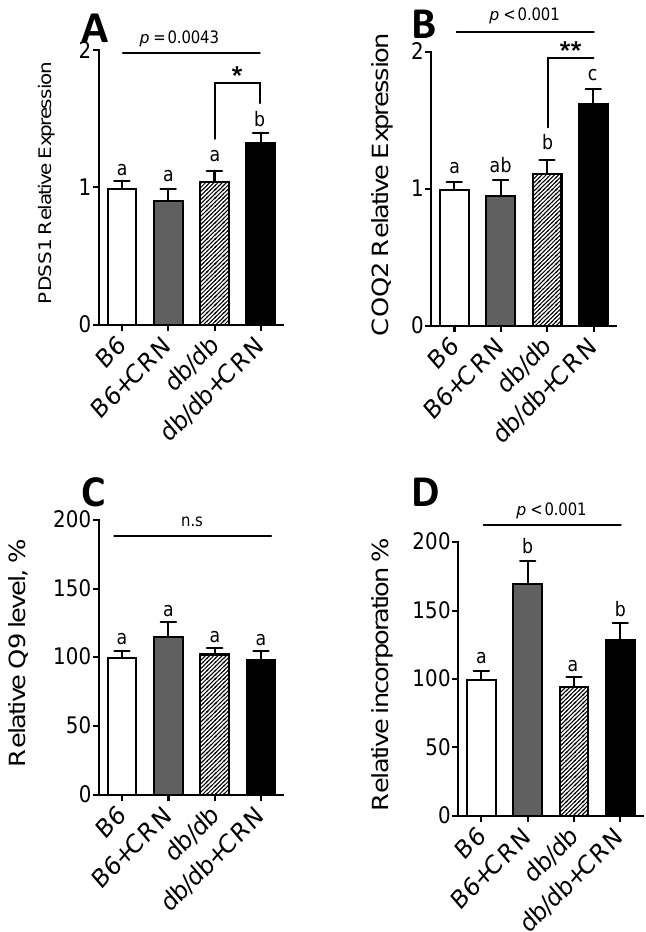
Figure 1. PDSS1 ( A ) and COQ2 ( B ) gene expression measured in 12-week-old C57B and db/db mice, with and without treatment of CRN at a 20 mM final concentration mixed with freely available drinking water during a treatment period of 4 weeks. Total CoQ9 levels in liver tissue from the same db/db and control mice treated with sham or CRN ( C ). Quantification of [3H]mevalonate incorporation into CoQ9 in liver tissue from control (C57B) and db/db mice treated with sham or 20 mM CRN in drinking water for 4 weeks ( D ). PBGD was used as a housekeeping gene for all gene expression analyses. Animal experiments were n = 5 for each condition unless stated otherwise. Values are represented as mean ± SEM in each group. Statistical analysis was performed using one-way ANOVA with multiple comparison differences denoted. (a,b) Different letters indicate significant differences in mean values from repeated-measures ANOVA ( p < 0.05). A p -value of <0.05 was considered significant. * and ** denotes a significance of p < 0.05, p < 0.01, respectively in all